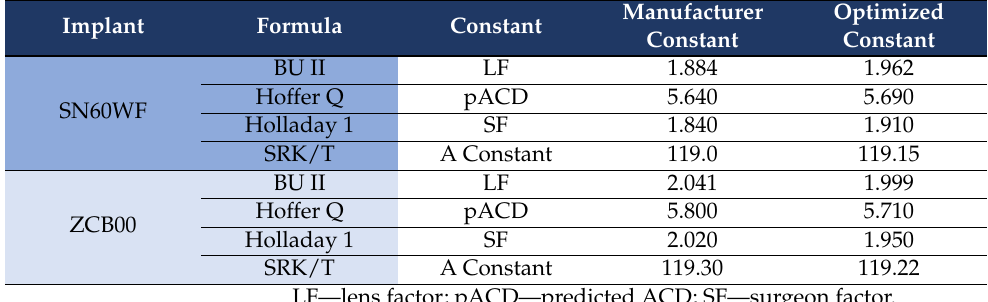
Table 1. Constants used for each